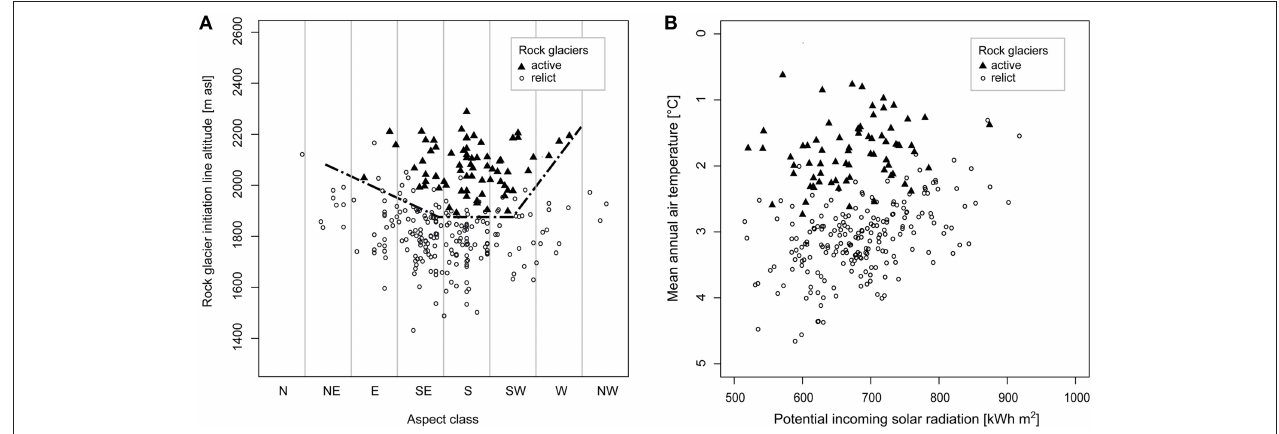
FIGURE 5 | Differences between active and relict rock glaciers in initiation line altitude and orientation (A) and mean annual air temperature and potential incoming solar radiation in snowfree months (B).